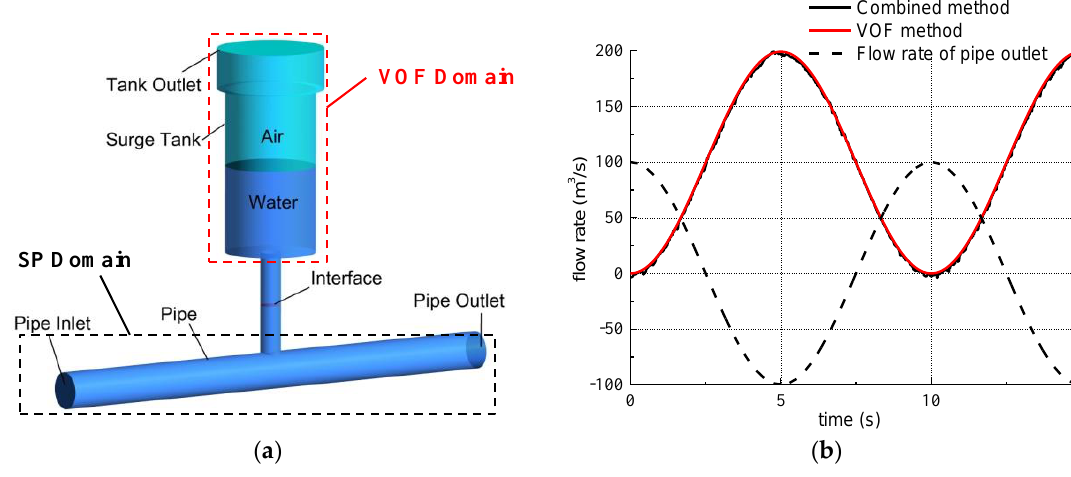
Figure 1. ( a ) Simplified pipe and surge tank model; ( b ) The flow rate across the shared interface obtained by two different methods and the flow rate of pipe outlet varied with the time.